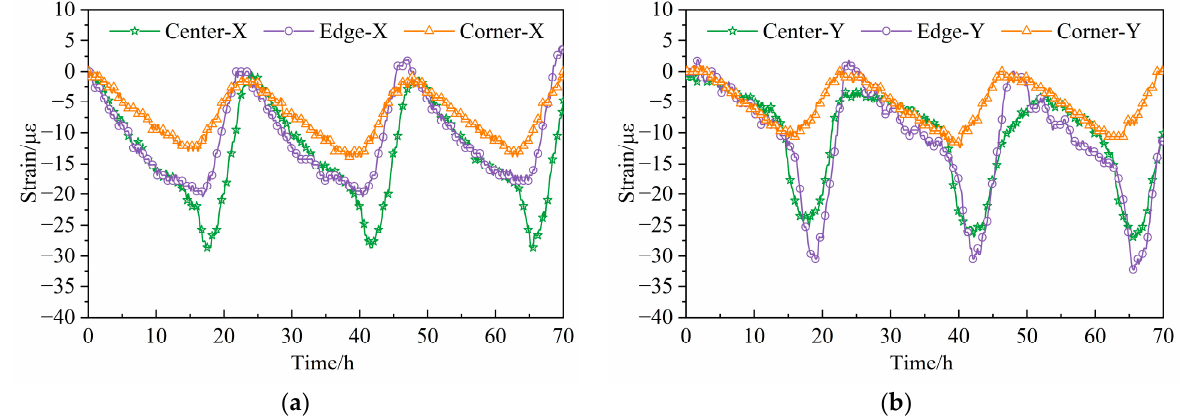
Figure 8. Horizontal strain time history curve of RCP. ( a ) X axis and( b ) Y axis.